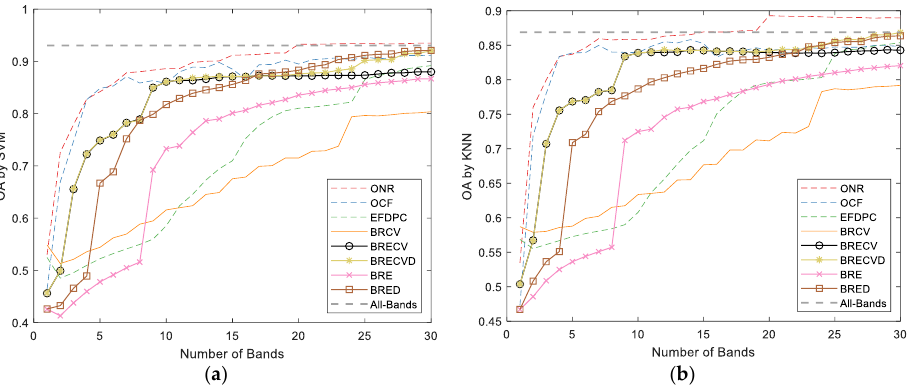
Figure 3. OA curves produced by SVM and KNN classifiers for the KSC data set. ( a ) The OA curves produced by SVM classifier. ( b ) The OA curves produced by KNN classifier.